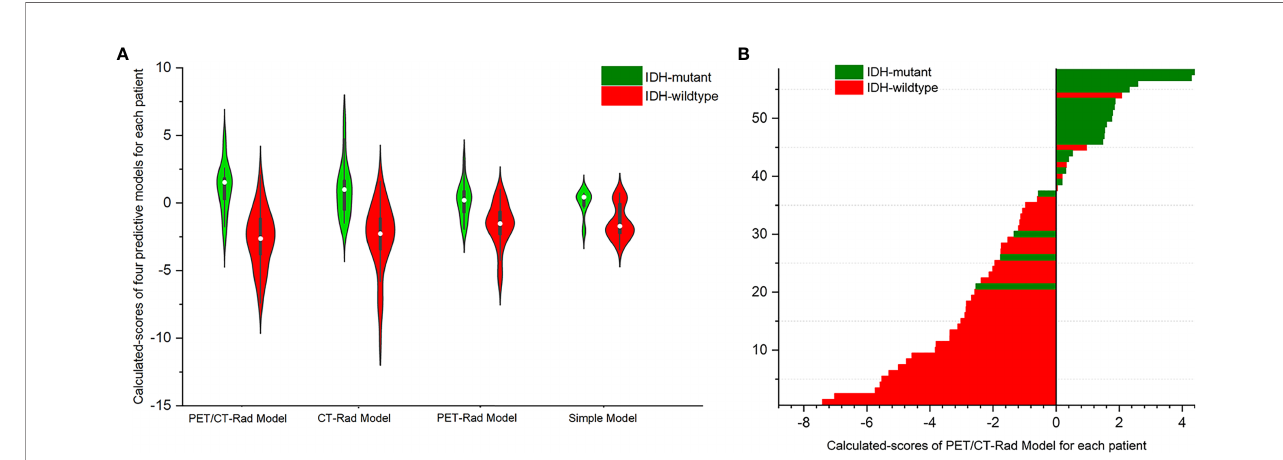
FIGURE 4 | (A) Violin plot of three radiomics models indicated different IDH genotypes has different calculated-scores. The white dot represents the median. The black rectangle is the range from the lower quartile to the upper quartile. The black line running up and down through the violin diagram represents the range from the minimal non-outlier value to the maximal non-outlier value. (B) Calculated-scores of the PET/CT-Rad Model for each patient in the glioma patient